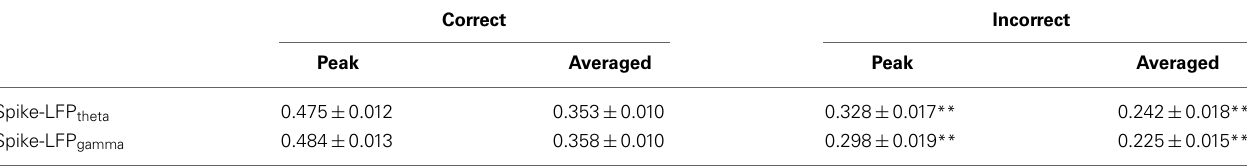
Table 4 | Spike-LFP correlation in correct and incorrect trials in the control group. Correct Incorrect Peak Averaged Peak Averaged Spike-LFP theta